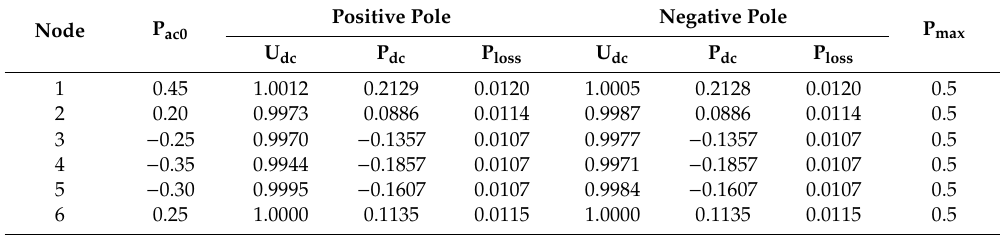
Table 4. Power flow calculation results in the single-point DC voltage control (p.u.).